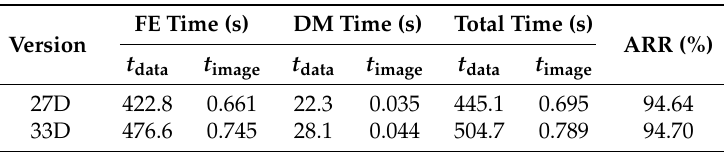
Table 8. Performance of the proposed method in terms of feature extraction (FE) time and dissimilarity measurement (DM) time. Experiments were conducted on the Vistex-640 database.